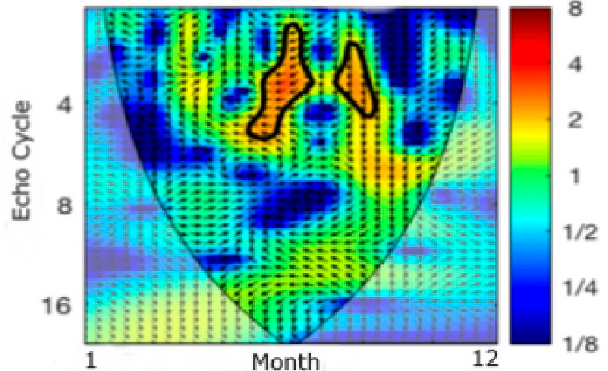
Figure 7. Same as Figure 4 but for a year.